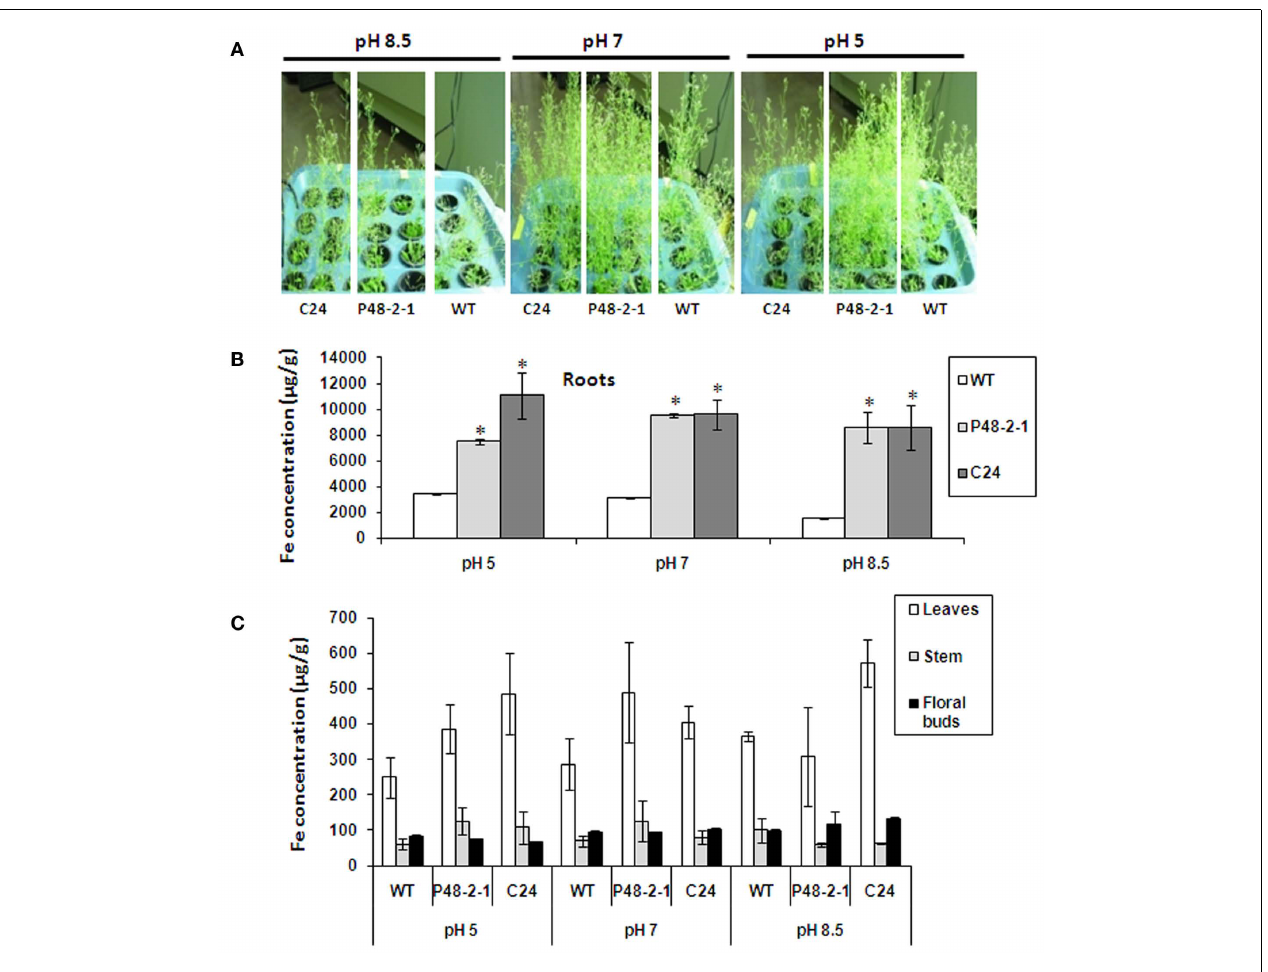
(B) Iron concentration of roots. (C) Iron concentrations of stems, leaves, and floral buds.Values are average of triplicates. Error bars represent SE.The asterisk (*) indicates statistically significant differences between wild-type and transgenics, determined by Student’s t -test, with P < 0.05.